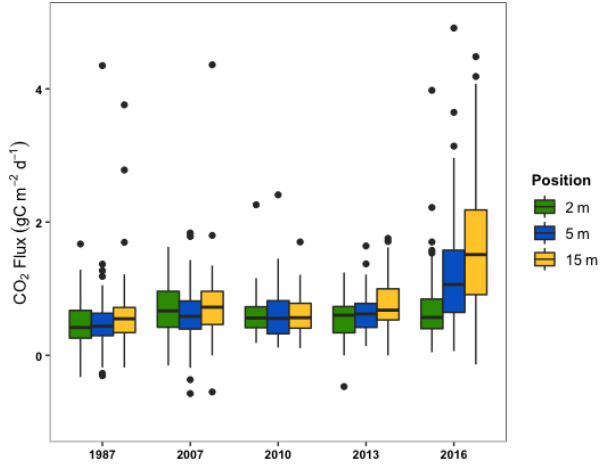
Figure 5. The box and whisker plots of CO 2 flux by sector and measurement location from the edge of the ditches in a field (i.e., 2, 5, and